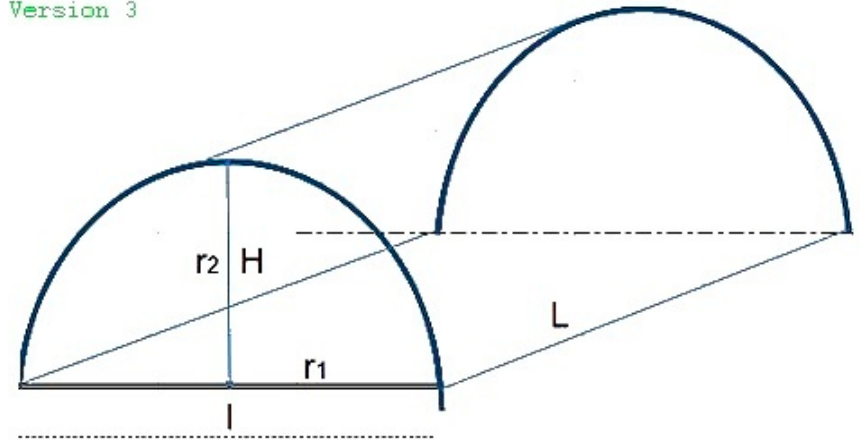
Figure 1. Elliptic design of the greenhouse.